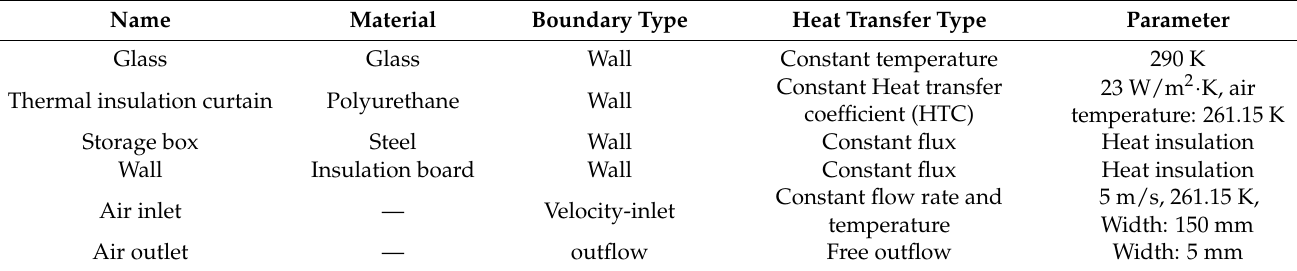
Table 6. Boundary conditions.